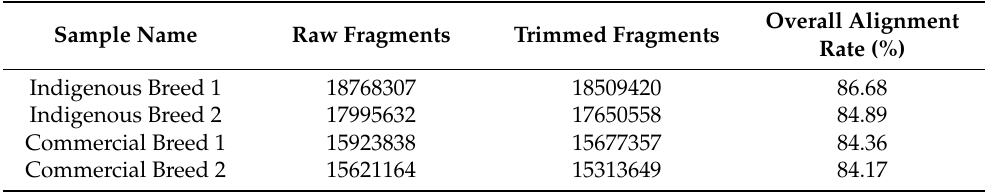
Table 2. Summary of sequence-read alignments to the reference